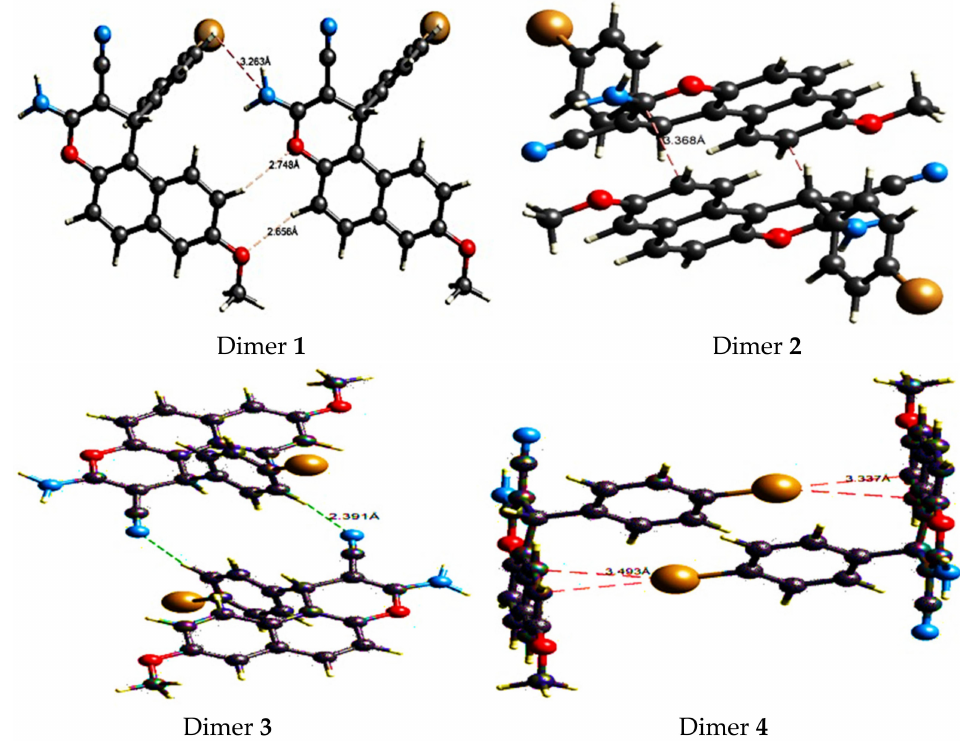
Figure 2. Molecular dimers 1 – 4 and the intermolecular contacts are shown as dashed lines and distances in